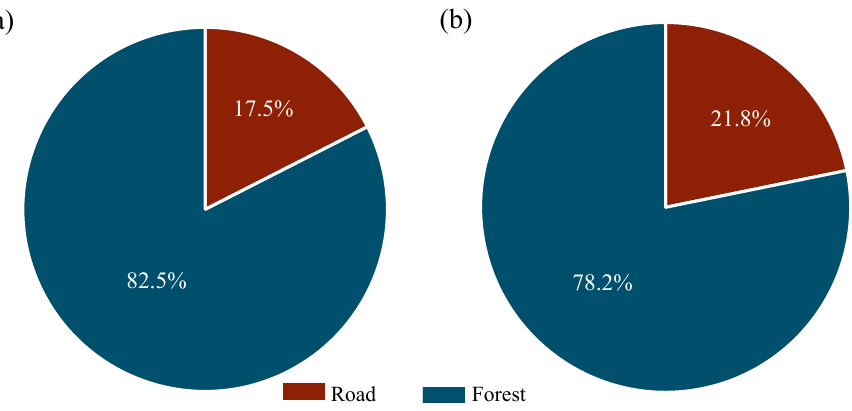
Figure 3. Contribution ratio of different sediment sources at ( a ) Arrow Bamboo Lake and ( b ) Rhino